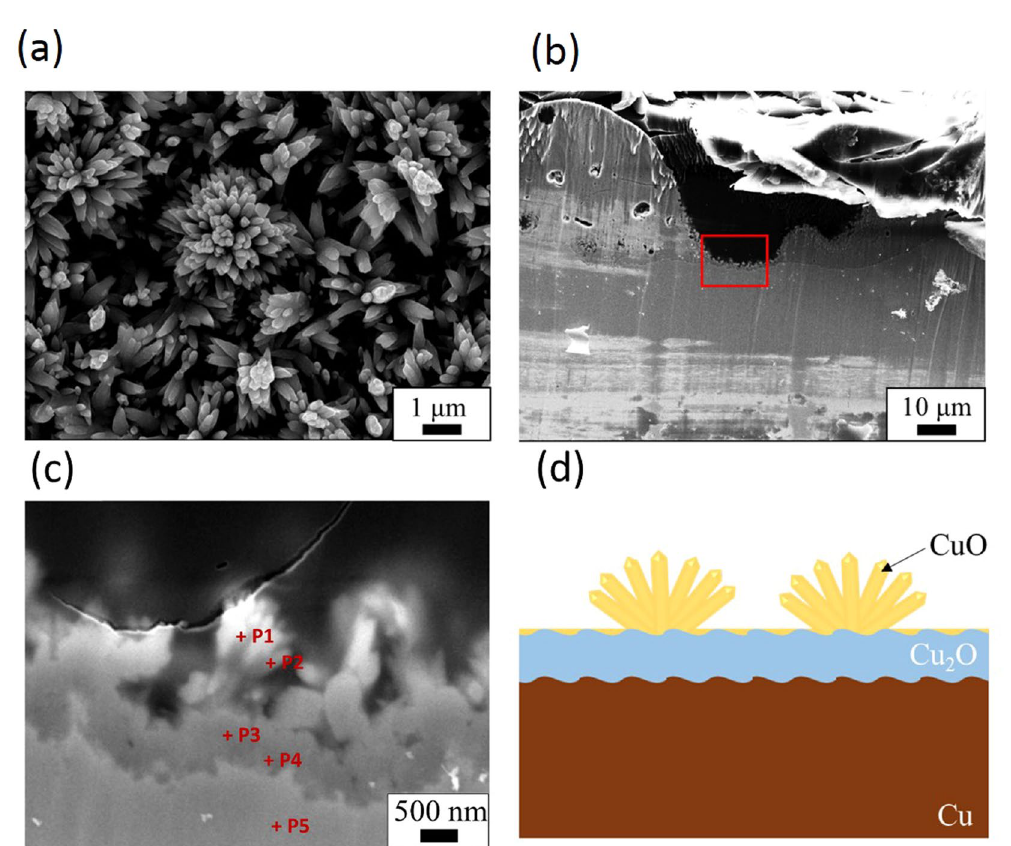
Figure 5. Cross-sectional images. ( a ) FE-SEM image of the sample surface after one week of SPSC. Nanoflowers were formed on the surface. ( b ) The cross-sectional FE-SEM image of ( a ) and ( c ) is the magnified view of the rectangular area in ( b ). P1-5 are the EDS point analysis position. The quantification result is indicated in Table 1. The black portion of the upper part is a resin that was used for cross-sectioning. ( d ) Schematic diagram of a cross-section of the samples prepared by the